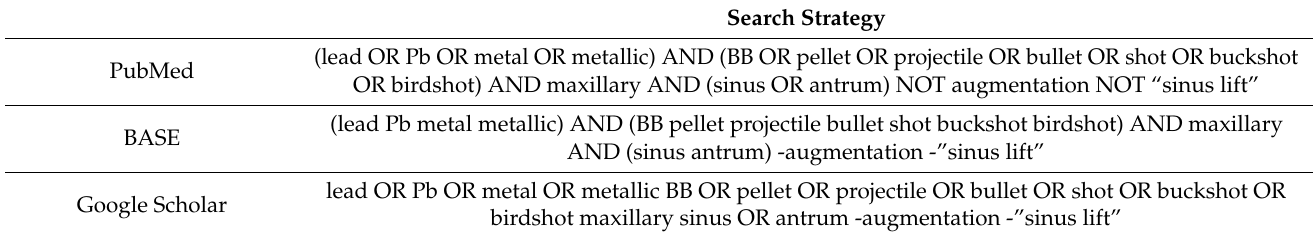
Table 2. Strategies to search for articles that served as materials for the systematic review. Search